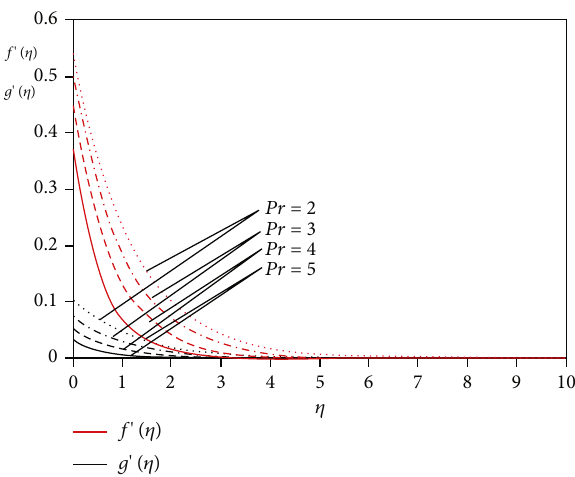
Figure 7: Velocity pro fi les a ff ected by the Prandtl number.